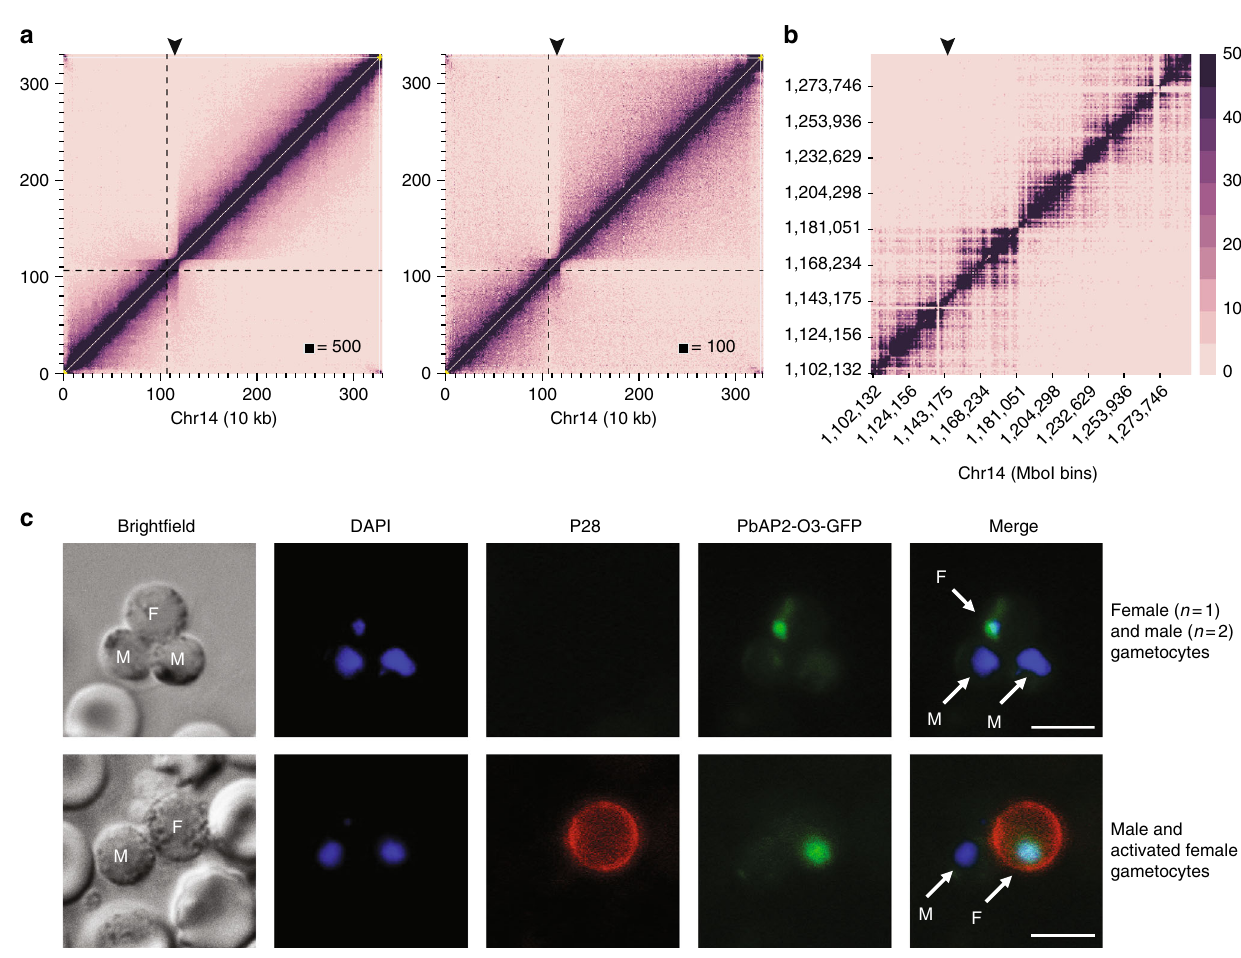
Fig. 4 Formation of superdomains on chr14 in gametocytes. a ICE-normalized contact count heatmap at 10 kb resolution of early gametocyte (left) and late gametocyte (right) chromosome 14 showing the separation of the chromosome into two superdomains. The dashed line indicates the location of the centromere, and the arrowhead indicates the position of PF3D7_1429200. b Smaller region of chromosome 14 centered on the domain boundary that is located inside PF3D7_1430000, a conserved gene with unknown function. c The homolog of pfap2 gene PF3D7_1429200 in P. berghei (PBANKA_1015500; pbap2-o3 ) has a nuclear localization in female gametocytes and gametes, but is not detected in male gametocytes. The top row shows male and female gametocytes. The bottom row shows a male and female gamete activated by mosquito ingestion, which triggers expression of the female-speci fi c surface protein P28. Male (M) and female (F) parasite are indicated in the bright fi eld and merged images. Scale bar denotes 10 μ